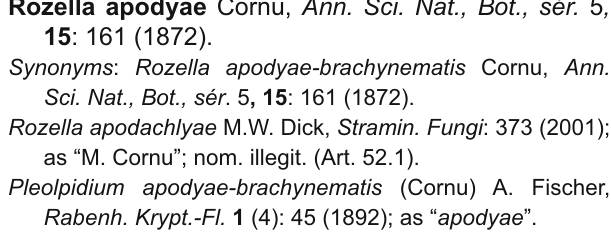
Fig. 6. Resting spores of Rozella allomycetis [strain CSF 55; Powell et al . 2017] in host Allomyces arbuscula . A. Resting spore formation. B. hyaline globose mass of material surrounded by a granular